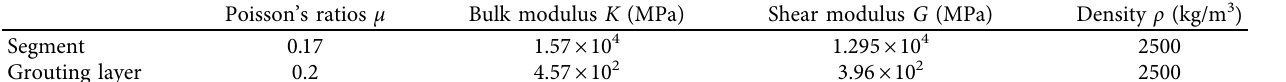
Table 2: Numerical simulation parameters.